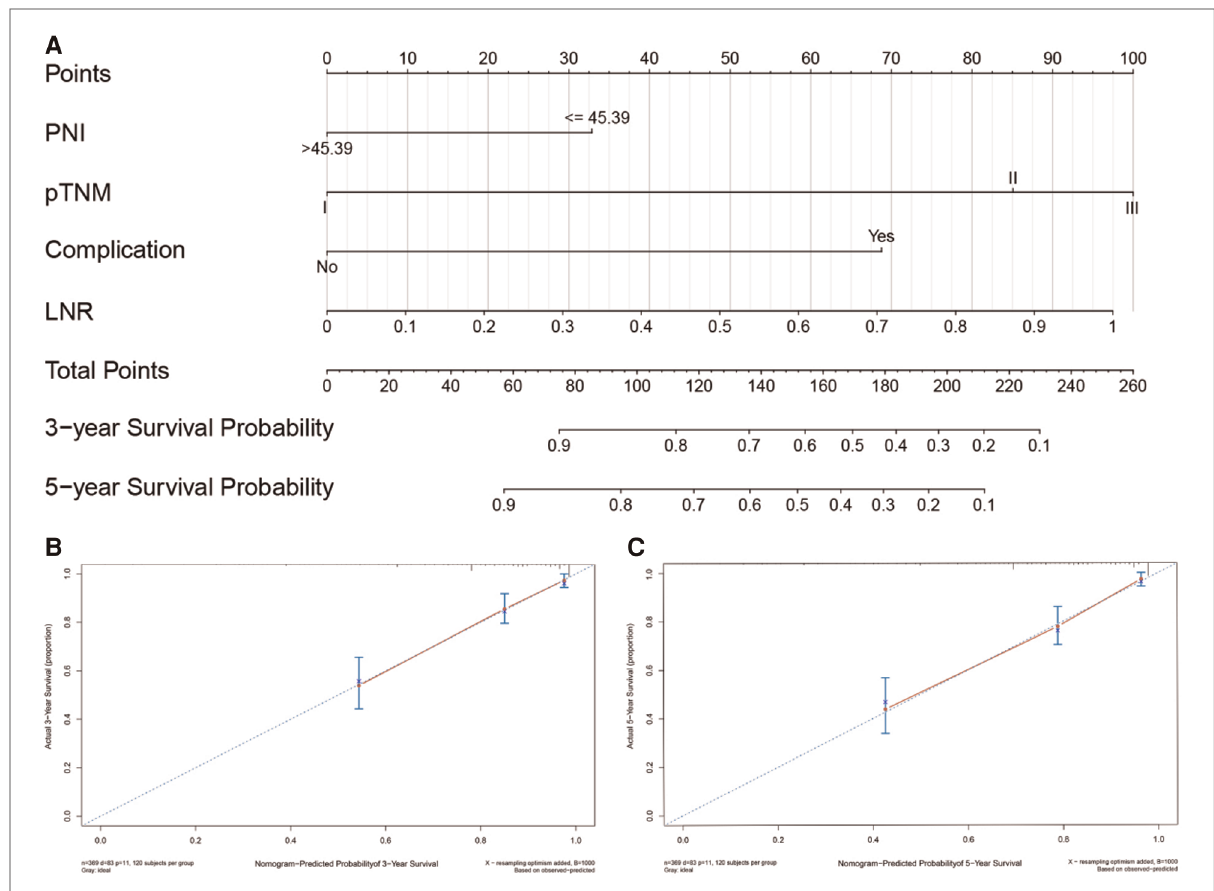
FIGURE 2 Nomogram for predicting 3- and 5-year overall survival (OS) of patients undergoing enhanced recovery after surgery (ERAS) combined with robotic radical gastrectomy. Nomogram for predicting the 3- and 5-year OS of patients undergoing ERAS combined with robotic radical gastrectomy (A). Calibration plot of the nomogram for ( B ) 3-year and ( C ) 5-year survival. PNI, prognostic nutrition index; LNR, Positive lymph node